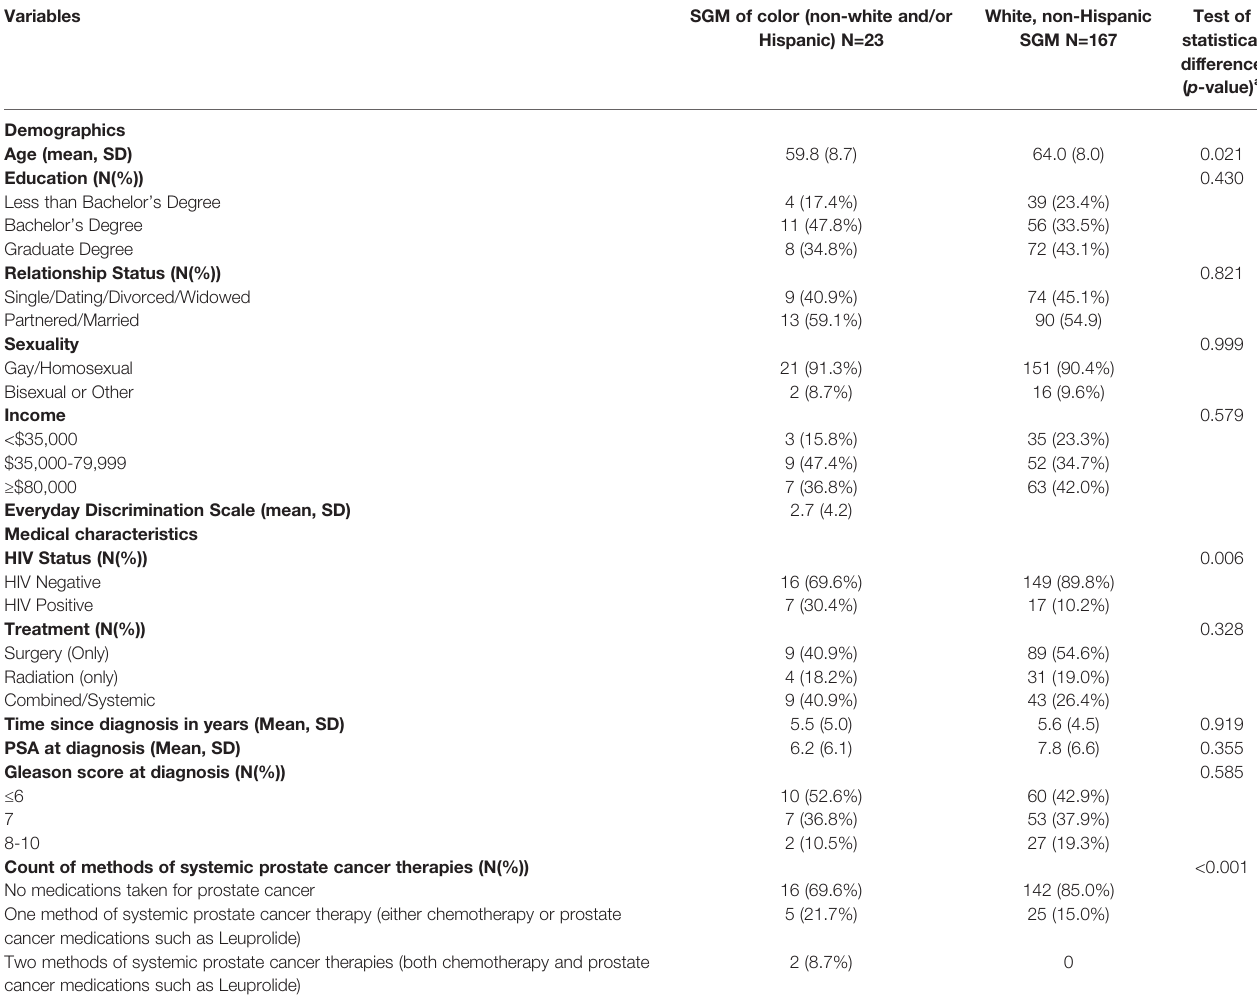
TABLE 1 | Characteristics of Participants by Race and Ethnicity Enrolled in Restore-1: A Survey of Sexual Minority Prostate Cancer Survivors (N=190).